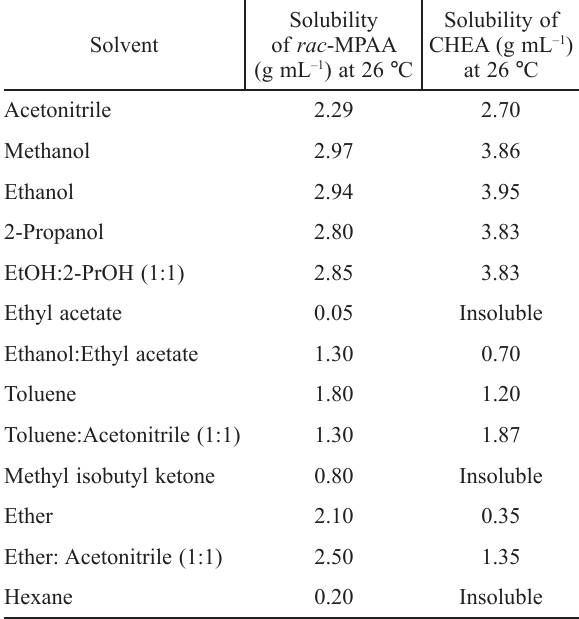
Table 1 – Solubility of MPAA, CHEA in organic solvents at ambient temperatures and pressures (solvents are listed in de-